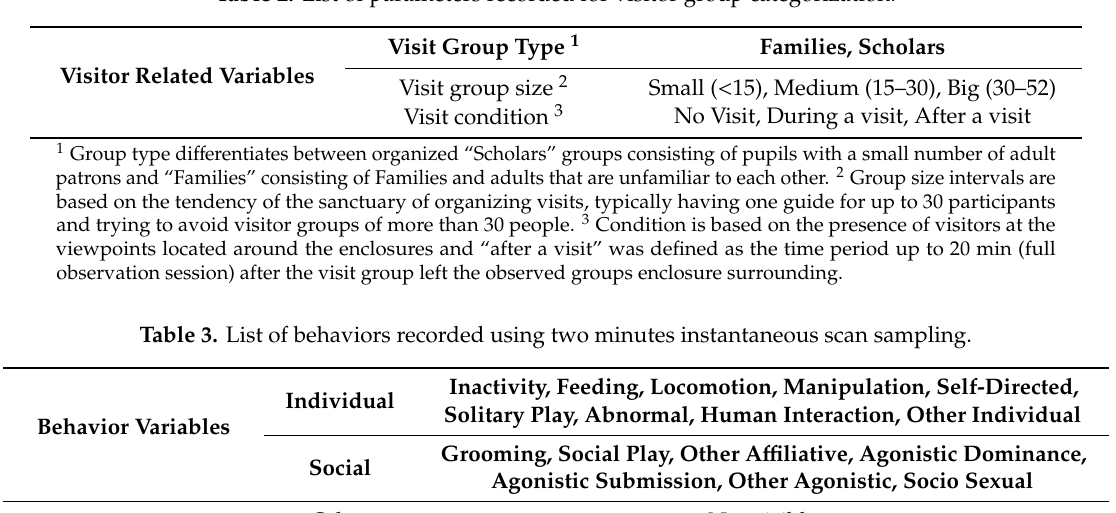
Table 2. List of parameters recorded for visitor group categorization.